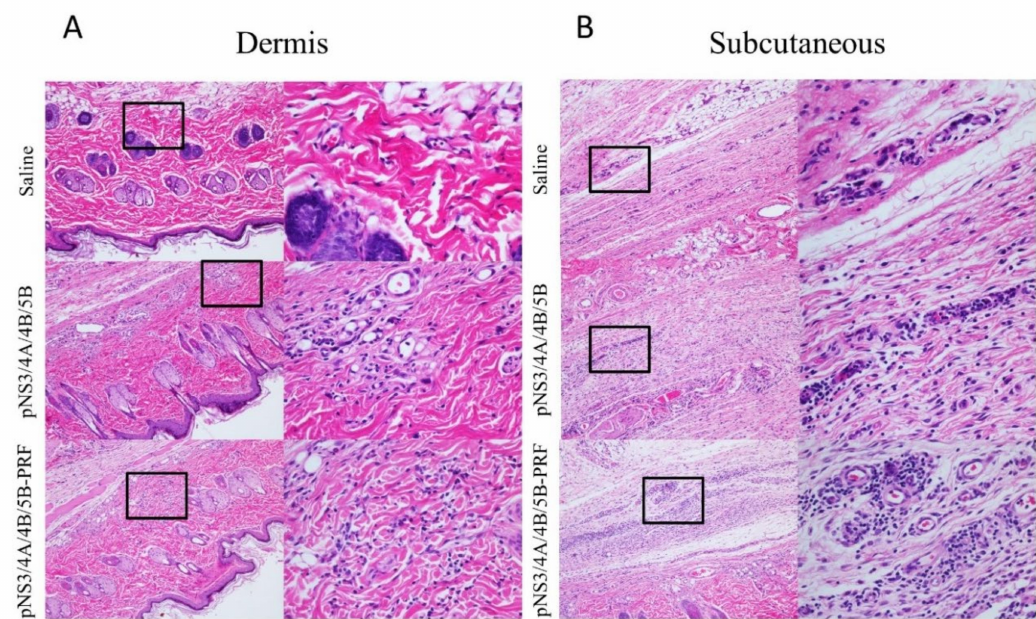
Figure 5. Histological representation of site of injection in Sprague Dawley rats. Histological representation of lymphocyte infiltration in the ( A ) dermis and ( B ) subcutaneous layer at the site of injection in rats vaccinated with Saline, pNS3 / 4A / 4B / 5B, and pNS3 / 4A / 4B / 5B-PRF. Images on left are 10 × objective, insets on the right are 40 × magnification. Table 2. Histopathological incidence at the dermal site of injection in Sprague Dawley rats. Group pNS3 / 4A / 4B / 5B-PRF pNS3 / 4A / 4B / 5B PBS Dermal